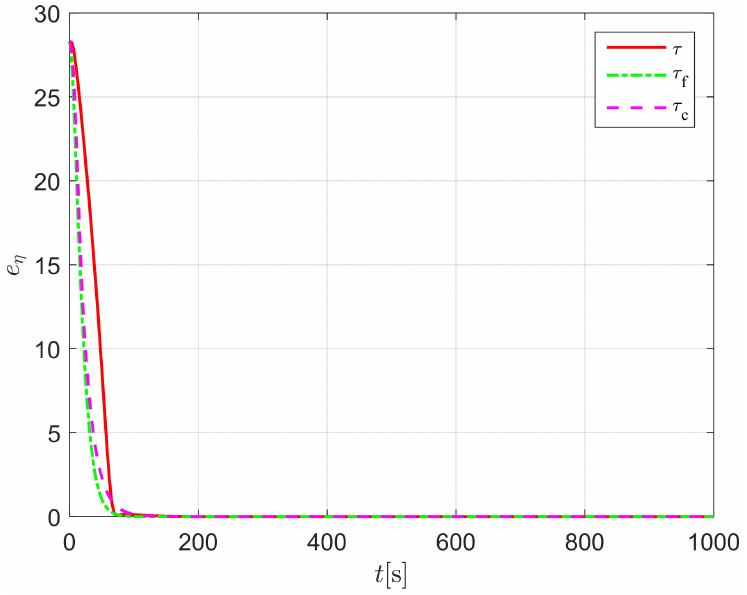
Figure 8. The time response curves of the control performance in Case